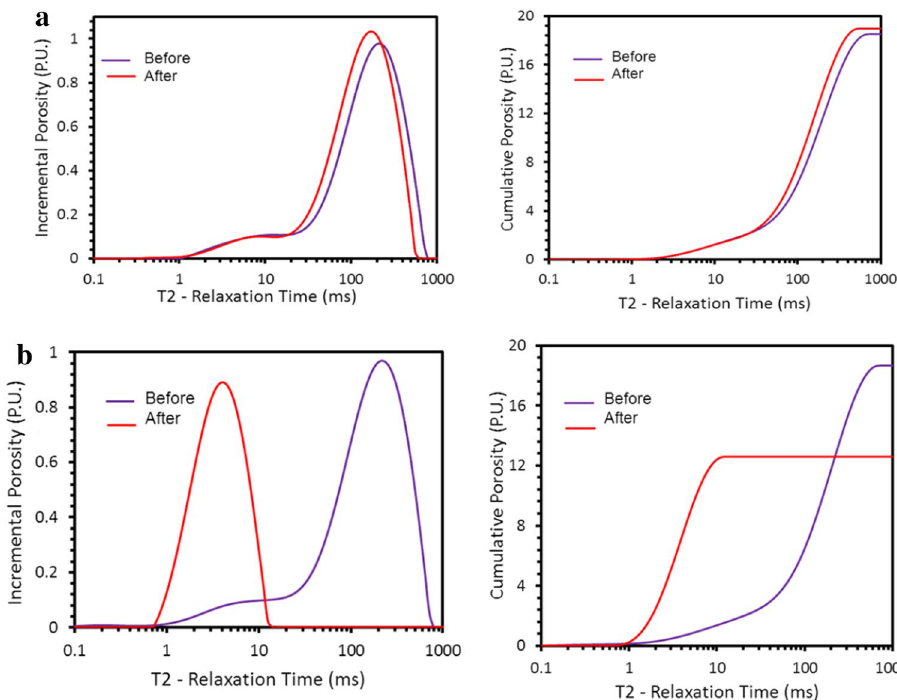
Fig. 8 a NMR T2 response curve for Berea sand stone core before and after damage at 25 °C using water as damaging fluid. b NMR T2 response curve for Berea sandstone core before and after damage at 25 °C using HCl as damaging